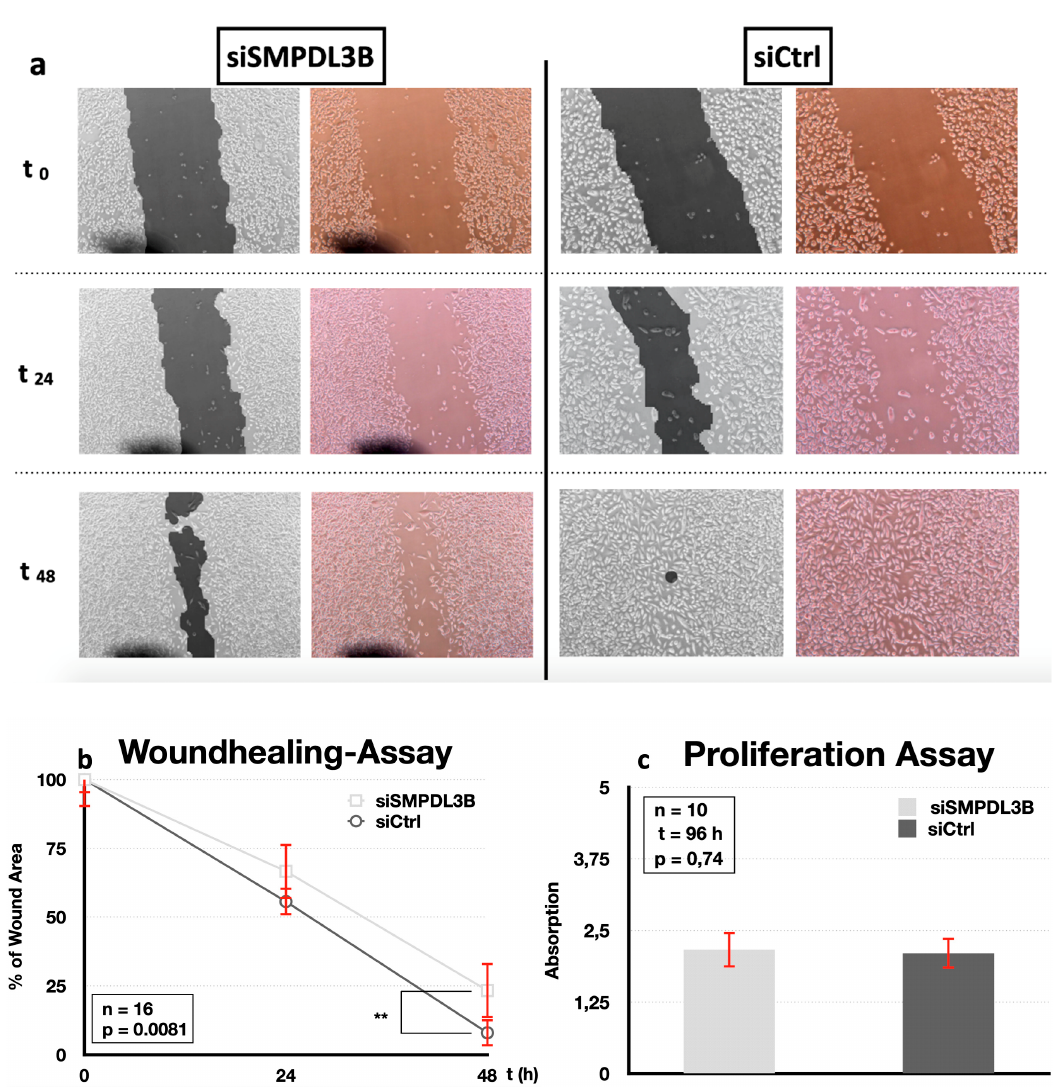
Figure 4. ( a ) Wound-healing migration assay in PC3 cells after siRNA knockdown of SMPDL3B ( n = 16). Images were taken at 0, 24, and 48 h after scratch. Calculation of the wound area was performed using TScratch software ® (black and white images), with a percentage of the wound area being given for each image. ( b ) Quantitative results of the migration assay which showed a significant reduction of the migration of siSMPDL3B-transfected cells compared to siCtrl after 48 h ( p = 0.0081). (** p > 0.01) ( c ) PC3 cell proliferation after siRNA knockdown was not significantly altered after knockdown of SMPDL3B ( n = 10, p = 0.74).